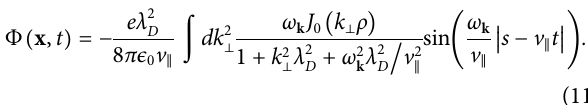
Frontiers in Physics |